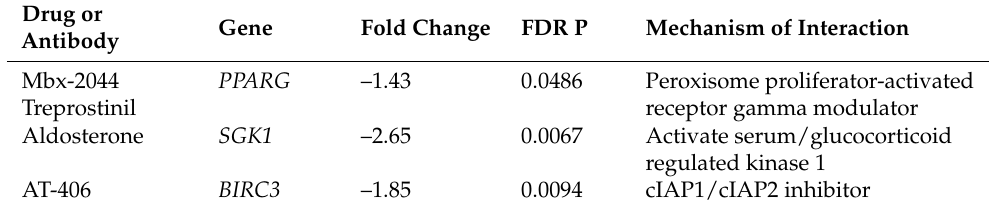
Table 2. Representative list of drug–gene interactions of HBP-associated DEGs to identify potential novel drug targets in the colon. The Drug Gene Interaction Database (https://www.dgidb.org/ search_interactions, accessed on 28 July 2021) was used to identify potential therapeutic targets in the colon for hypertension management and